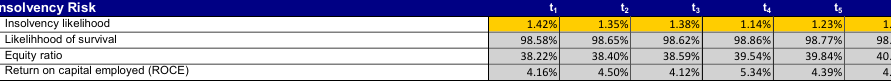
Figure 4. Insolvency risk.